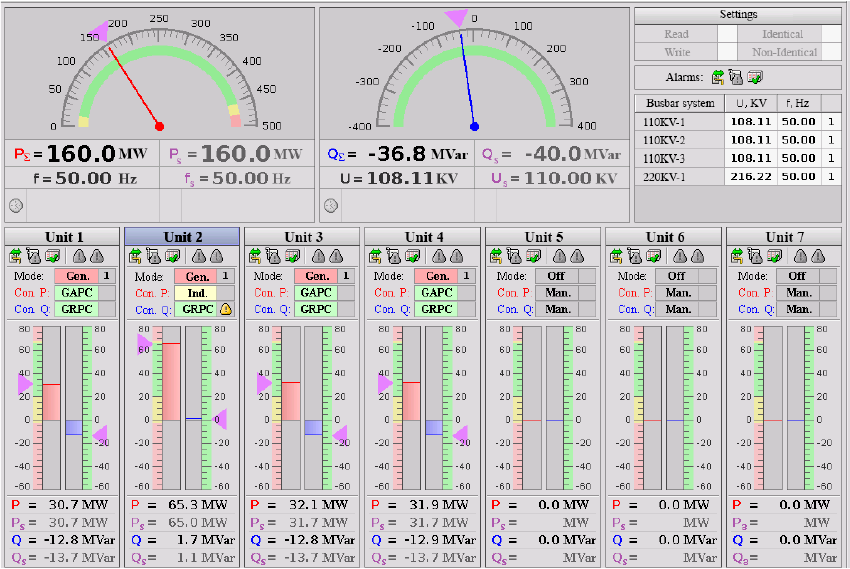
Figure 9. The main window of the digital AGC system: unit 2 has constraints on steady-state sta- bility.